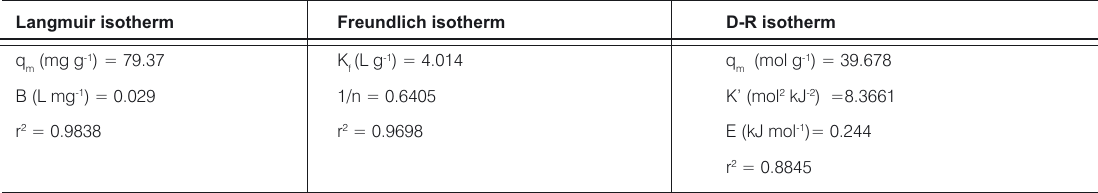
Table 1a. Equilibrium Isotherm Parameters of sorption of CR by PKC.